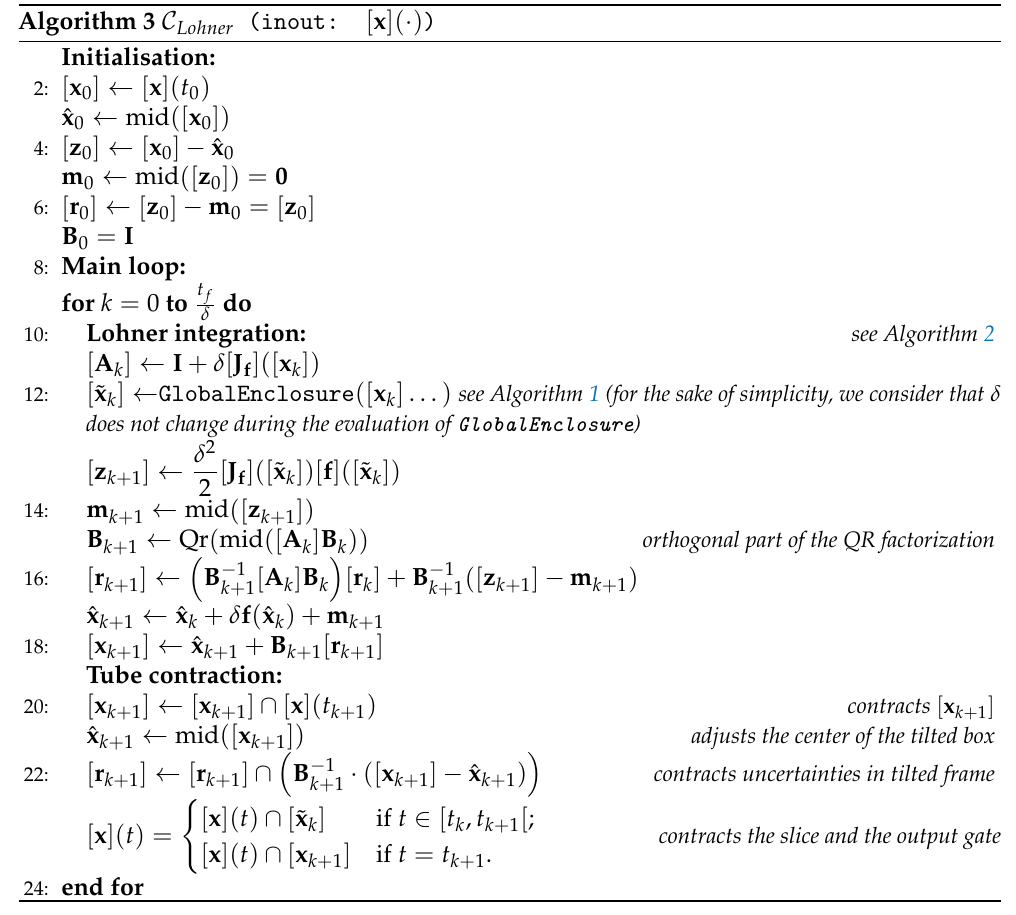
Algorithm 3 is the implementation of our Lohner contractor for tubes of